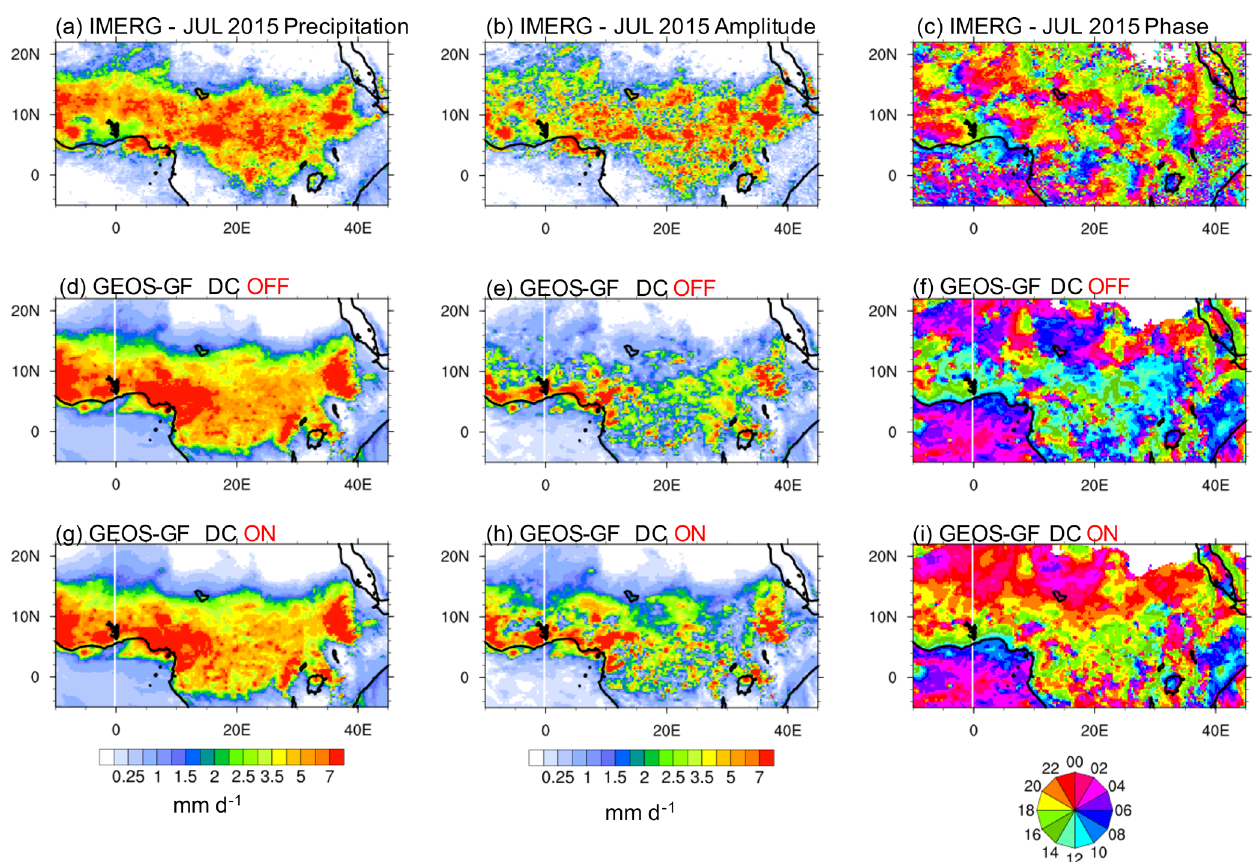
Figure 16. The July 2015 monthly mean precipitation, amplitude, and phase of the diurnal harmonic over a portion of equatorial Africa. The top panels (a–c) show the quantities of the GPM IMERG retrieval. In the middle (d–f) and lower rows (g–i) , panels show model simulations with the diurnal cycle closure turned off and on,